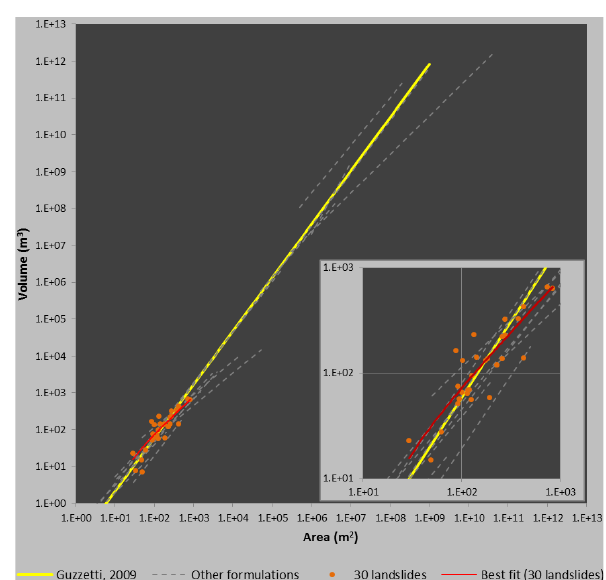
Fig. 10. Area versus Volume ( V L ) projection for the empirical for- mulations. Detail of the Madeira landslides area and volume ranges (right bottom). Other formulations relates to all the formulation used in Guzzetti